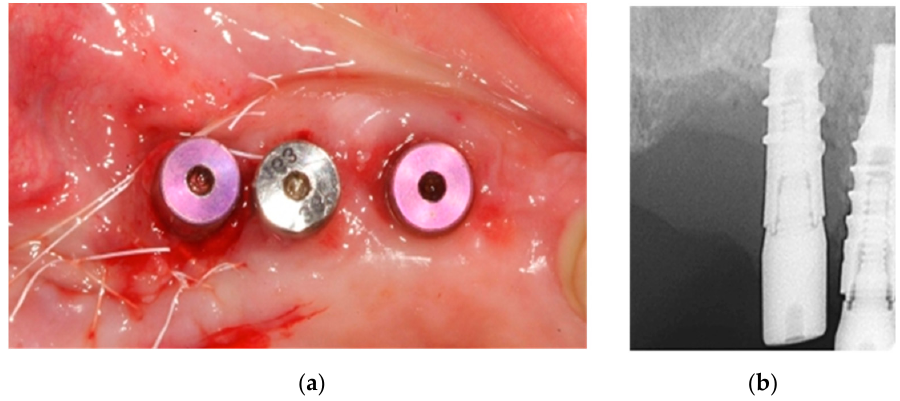
Figure 12. ( a ) Stress-free suture; ( b ) Resulting bone defect in post-surgical intraoral X-ray.